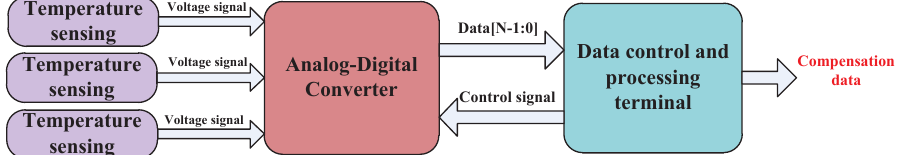
Figure 3. Architecture of the ranging compensation temperature-sensing